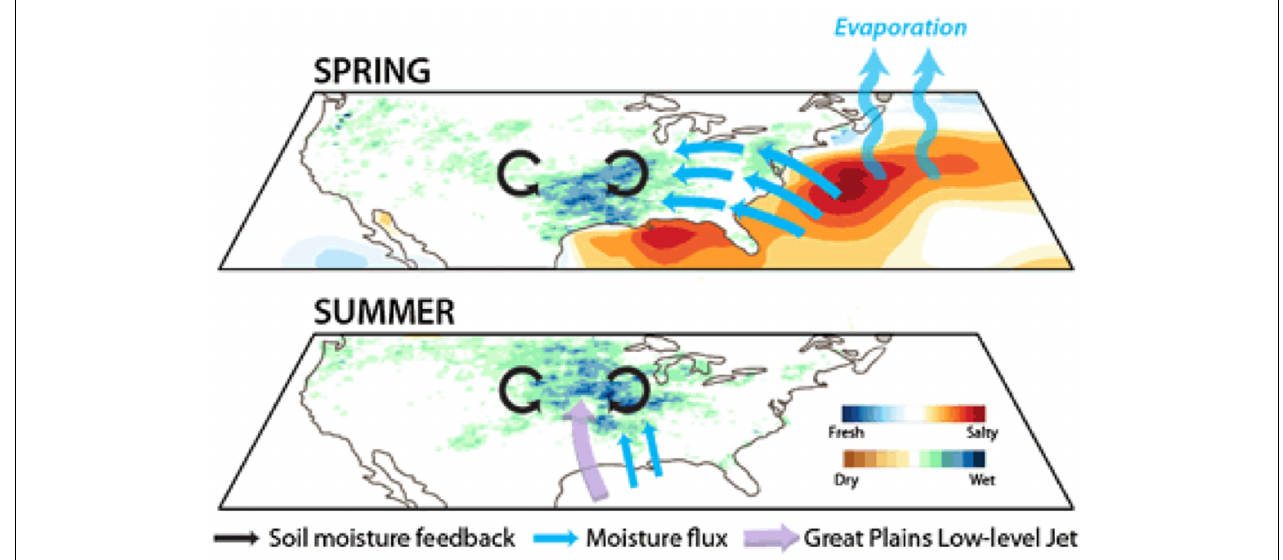
FIGURE 10 | Satellite SSS data improves prediction of land precipitation. Schematic figure illustrating the soil moisture mechanism bridging the 3-month time lag between springtime salinity anomalies and summer precipitation in the United States Midwest: in the western North Atlantic, higher springtime salinities are an indicator of enhanced moisture export onto the continental United States which converges in the South. This greatly increases soil moisture there, allowing for enhanced evaporation and leading to more atmospheric convection on land (upper panel). The intensified convection on land draws in more moisture from the Gulf of Mexico and leads to the enhancement of the Great Plains Low Level Jet, which carries moisture to the upper Midwest in summer (bottom panel). Adapted from Li et al. (2018), reproduced under Creative Commons